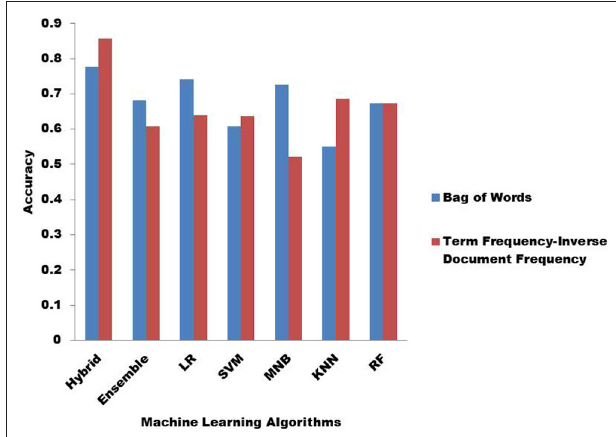
FIGURE 4 | Classification accuracy with Bag of Words (BoW) and Term Frequency-Inverse Document Frequency (TF-IDF).